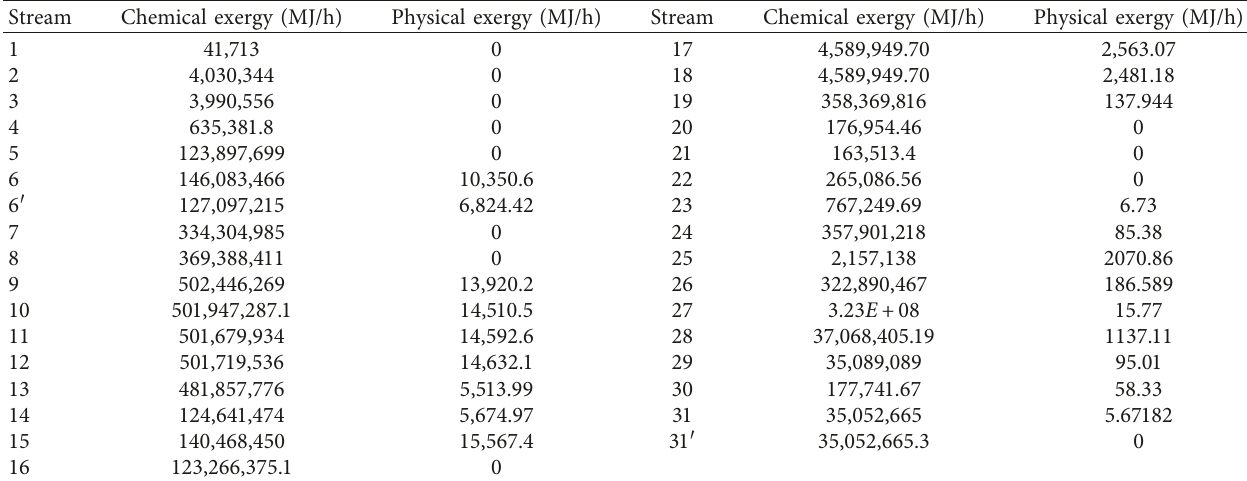
Figure 3: Simplified block diagram of nitrobenzene production via benzene nitration. Table 2: Chemical and physical exergy of process